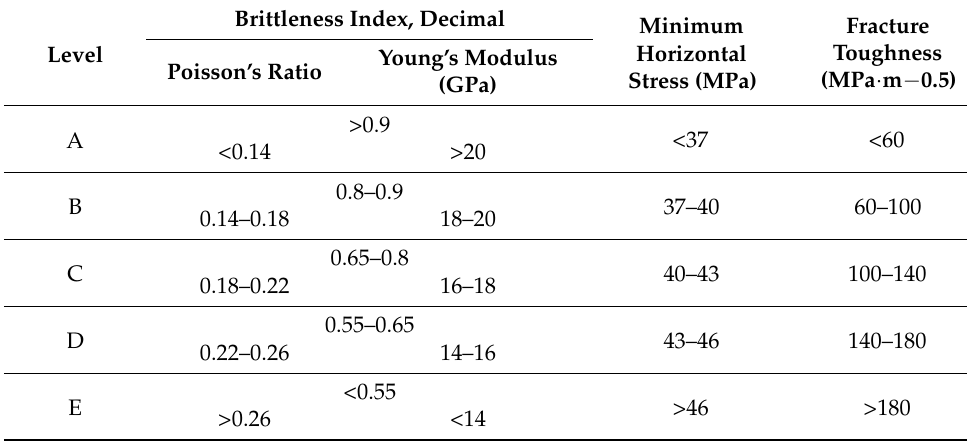
Table 4. Parameter range of different engineering sweet spot.